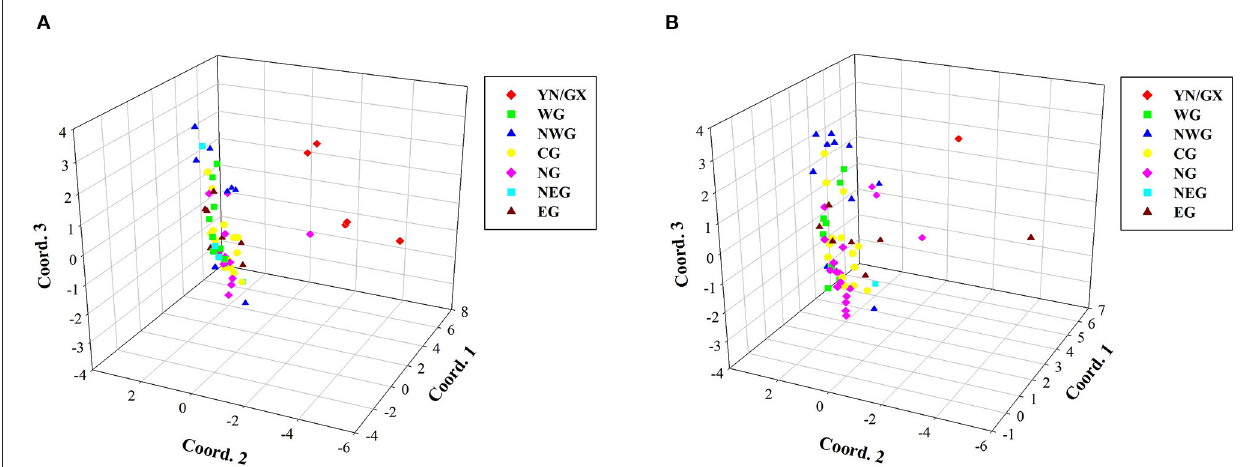
FIGURE 5 | Comparative PCoA plots of core germplasm sets. (A) A core set of 60 confirmed accessions considering the geographical location. (B) A core set of 60 confirmed accessions without considering the geographical